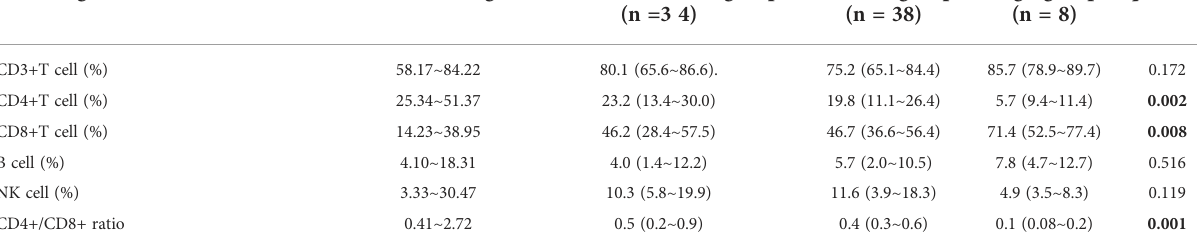
TABLE 5 Frequency of immune cells subsets analysis.